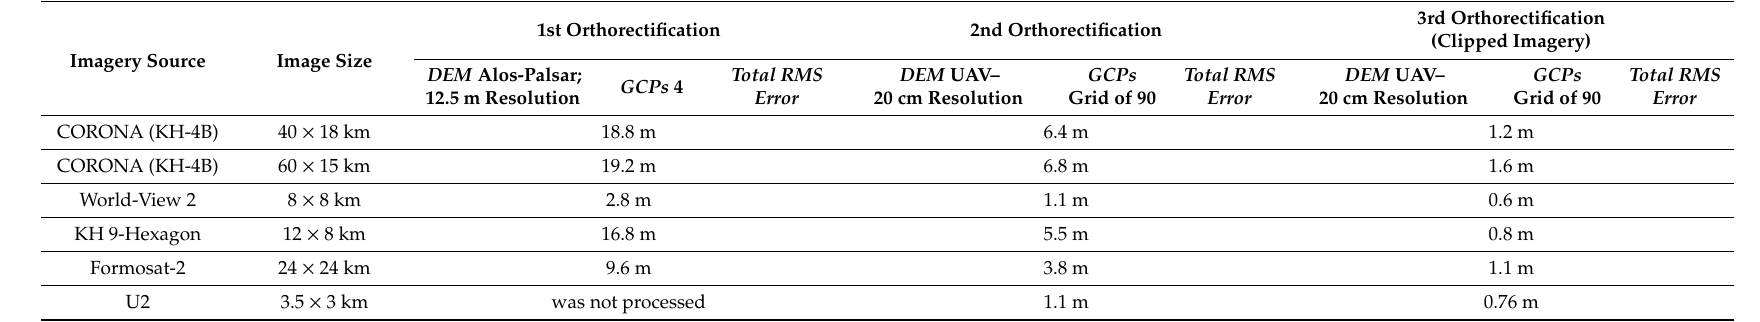
Table 1. Overview of total rot mean square (TRMS) by image size, data source, reference layer, and processing